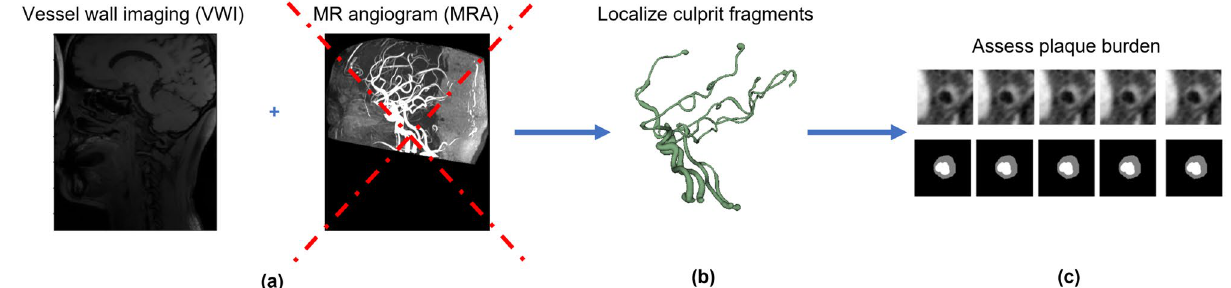
Figure 1. Schema for proposed modification and its impact on the current workflow for vessel wall imaging. Typical workflow for quantitative plaque assessment ( a ) acquires both VWI and MRA in the same session, ( b ) extracts and locates vessel segments of interest, and ( c ) identifies the corresponding region in VWI, performs detailed lumen, vessel wall segmentation to quantify plaque burden, and identifies the most stenotic slice. This study investigates the feasibility to rid the MRA module in this procedure.